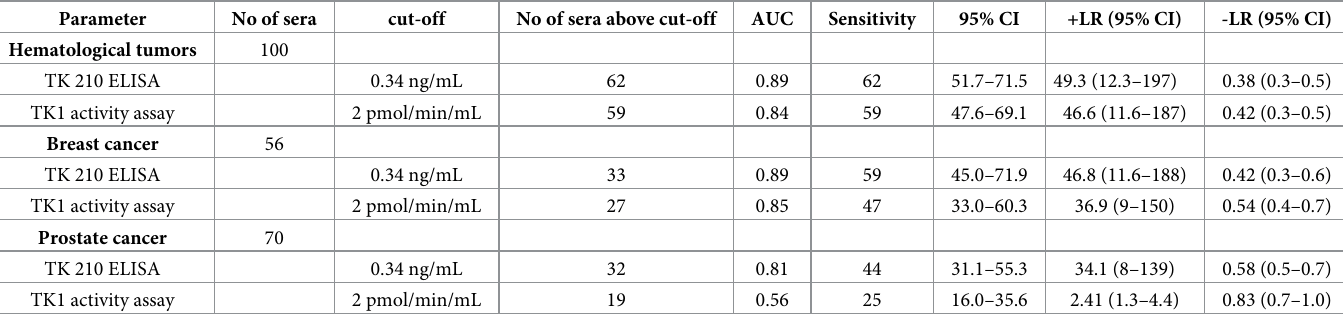
AUC: area under curve, +LR = positive likely hood ratio and–LR = negative likely hood